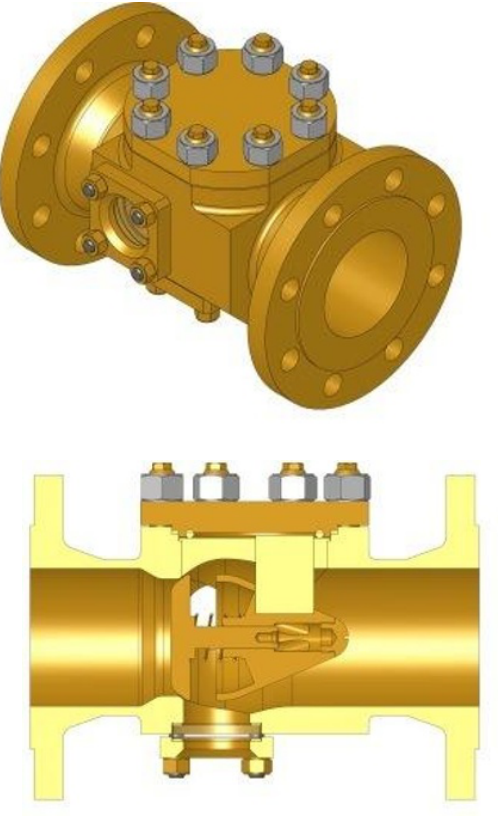
Fig. 5. Axial check valve – Top-entry